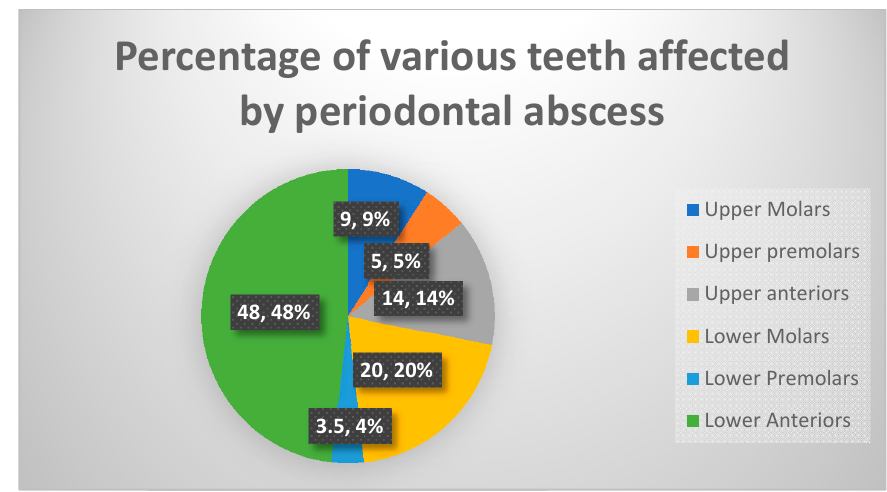
Figure 1. Frequency distribution (%) of periodontal abscess according to the affected teeth.